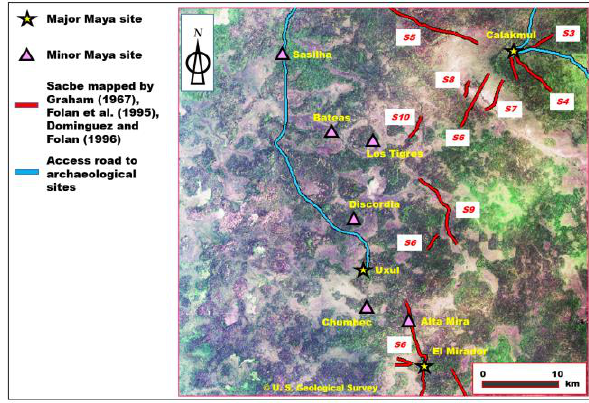
Figure 3. Previously mapped sacbe segments with some known ancient Maya sites.